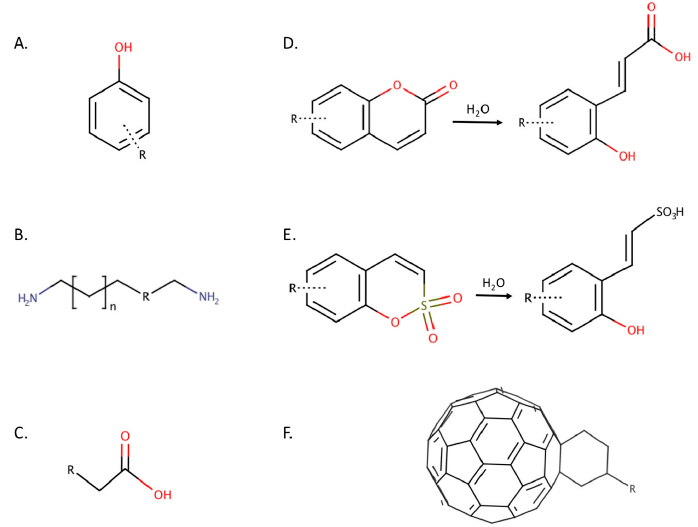
Figure 2. ( A ) Phenol; ( B ) Polyamine: n is an integer, R is either an N or C atom; ( C ) Carboxylic acid ( D ) Coumarin and hydrolysis product; ( E ) Sulfocoumarin and hydrolysis product; ( F ) Fullerene